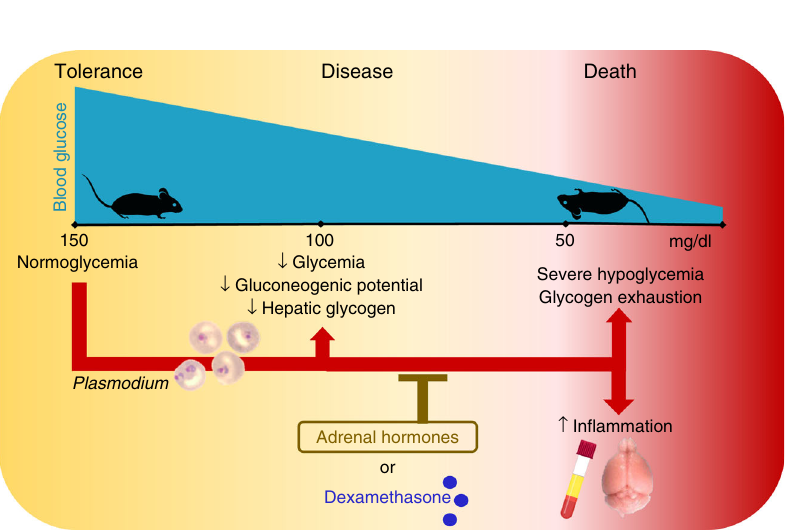
Fig. 10 Adrenal hormones confer tolerance to malarial disease. Blood glucose levels decrease slightly, hepatic glycogen is consumed and the expression of a main gluconeogenic enzyme, glucose-6-phosphatase is lowered in murine malaria models without affecting survival. However, when adrenal hormone production is abolished, glycogen stores become exhausted and glycemia declines further until lethal glycemia levels are reached. This hypoglycemia is accompanied by increased circulatory and cerebral cytokine levels and can be prevented by supplementing dexamethasone. These effects are independent of the parasite load, indicating that adrenal hormones are crucial in mediating tolerance to malarial